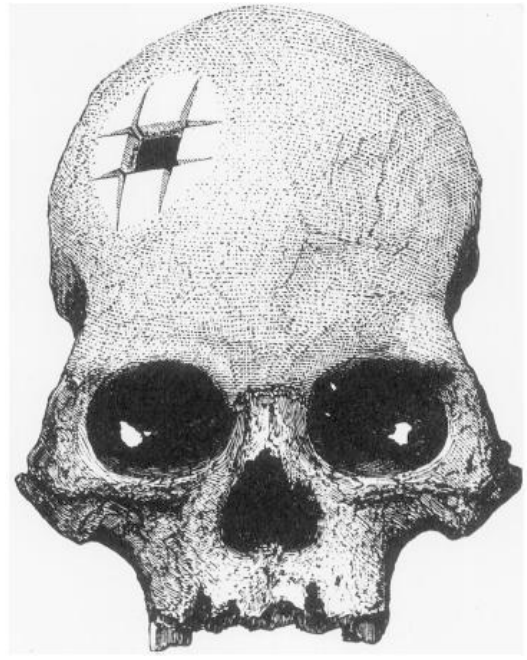
Figura 1. Crânio encontrado por Squier (1821-1888) em Cuzco, Peru, com um pequeno orifício retangular de 15 X 17 mm, datado por volta de 1500–1400